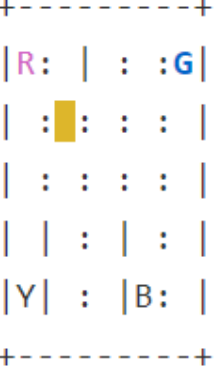
Figure 6. Rendering of the Taxi